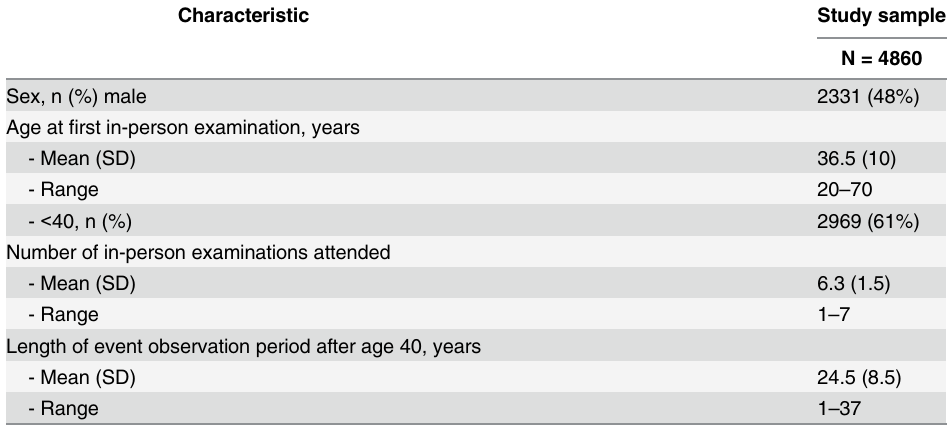
Table 1. Framingham Offspring Study Sample Examinations and Observation